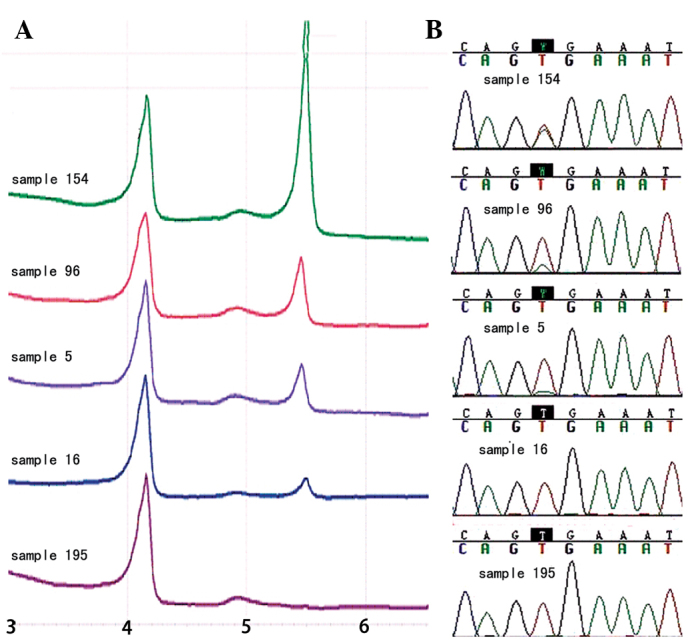
Representative results of denaturing high-performance liquid chromatography (DHPLC) and sequencing for BRAF V600E mutations. (A) BRAF V600E mutations were detected in several samples using multiplex allele-specific PCR. A low level mutation peak was observed in sample 16. (B) BRAF V600E mutations were detected by direct sequencing; a low level mutation was observed in sample 5 and no mutation was identified in sample 16.